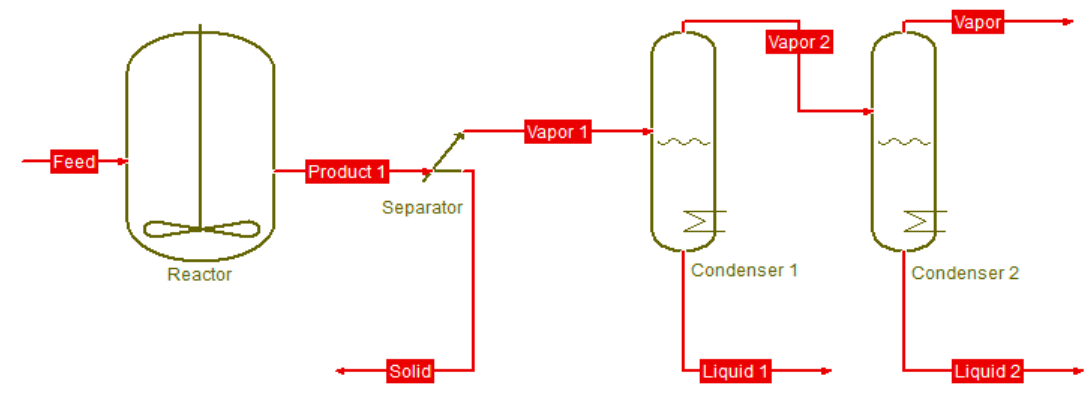
Figure 1. Process simulation flowsheet for batch pyrolysis study.